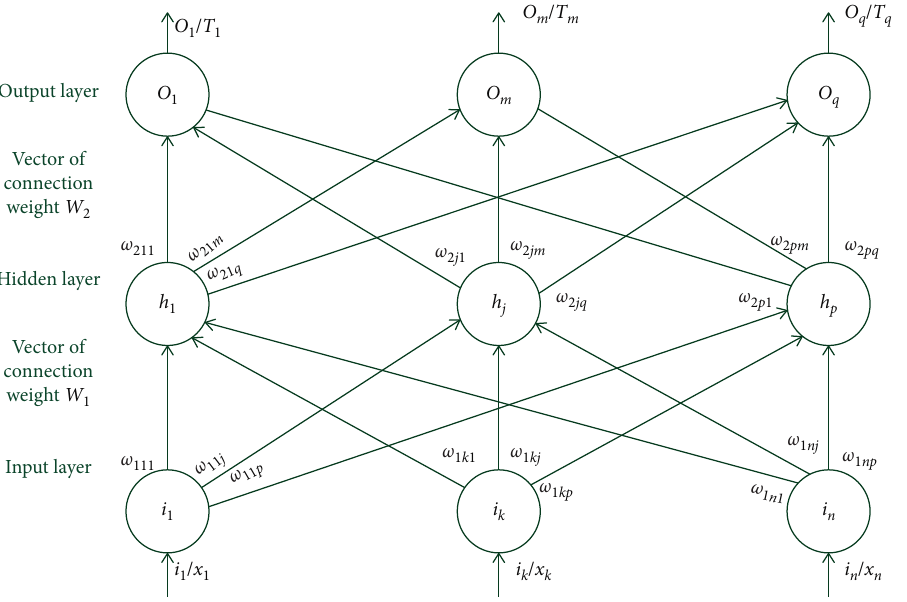
Figure 2: Computational architecture of